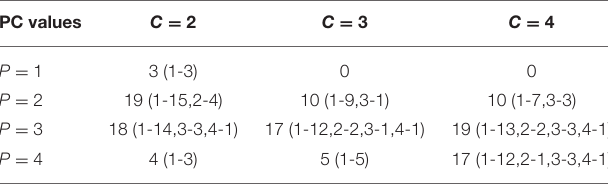
TABLE 7 | Distribution of positive PC values and theme